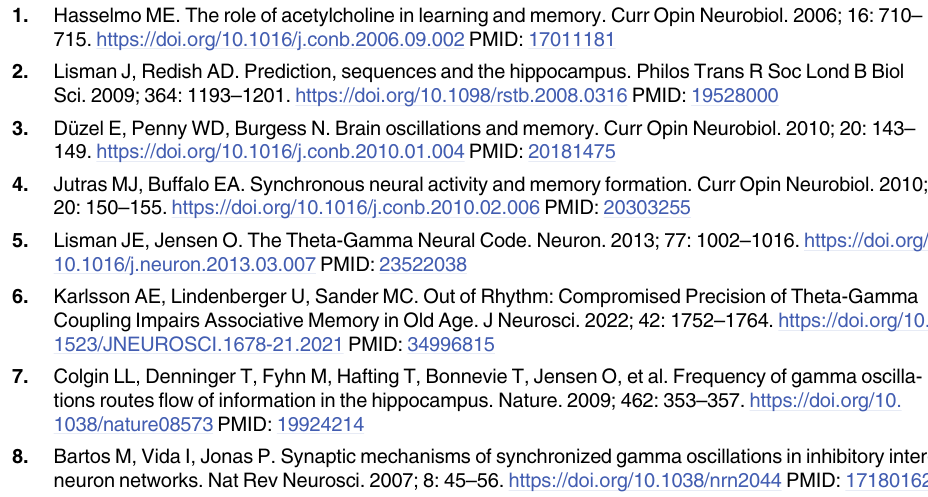
S3 Fig. Simulations in Fig 6 rerun with conduction delays set uniformly to 1.6 ms produce similar results. (TIF) S4 Fig. Effect of increasing chemical synapse strength in shunting networks with unphysio- logically strong gap junctions. (TIF) S5 Fig. Values for g floor do not substantially affect oscillatory frequency or power. L